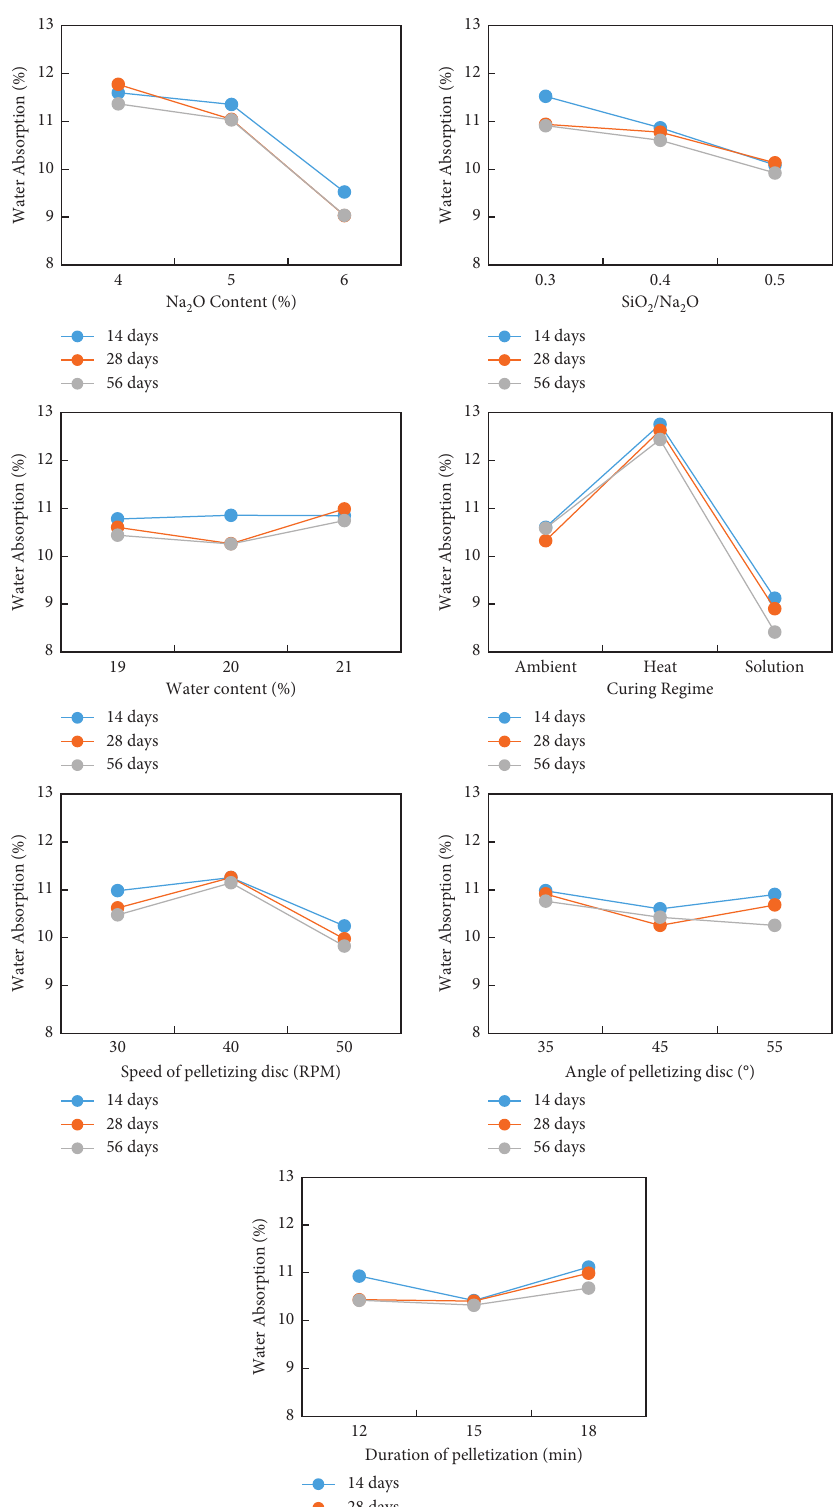
Figure 7: Response index relationship for water absorption with combined